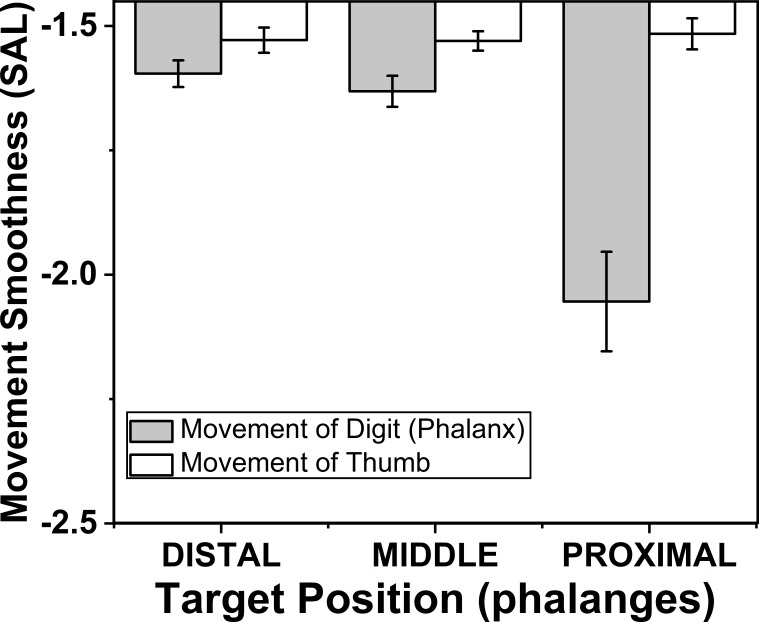
Change of smoothness of phalanx and thumb for different target phalanges.The smoothness of the movement of digit (phalanx) and thumb was determined using spectral arc length method. When the spectral arc length value was large, lesser was the smoothness of the movement. The smoothness of the phalanx movement reduced significantly (p < 0.001) when the target position was changed from distal to proximal phalanx. There was no significant difference of smoothness of thumb movement when target positions were changed. The columns and bars indicate means and standard error of means.